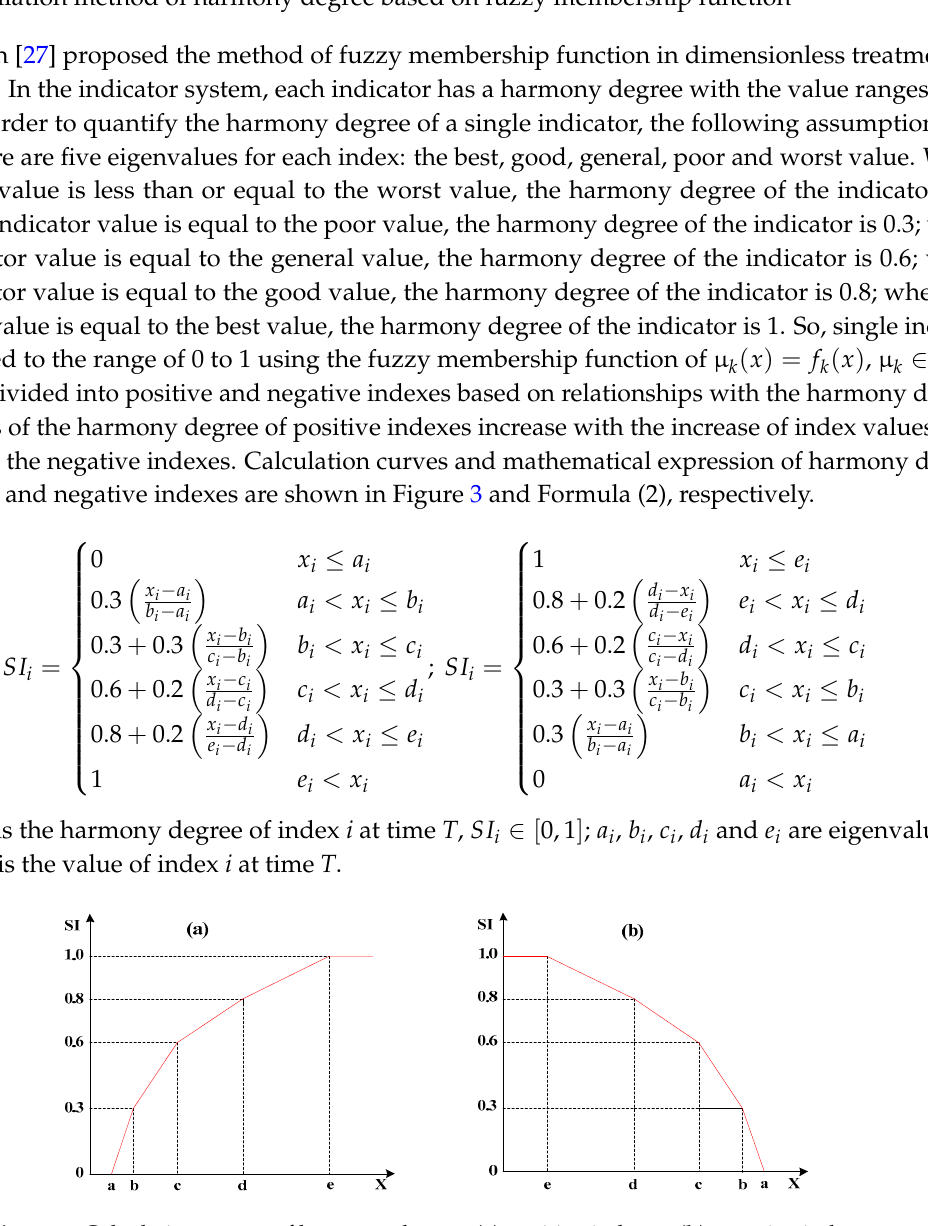
Figure 3. Calculation curves of harmony degree: ( a ) positive indexes; ( b ) negative indexes.